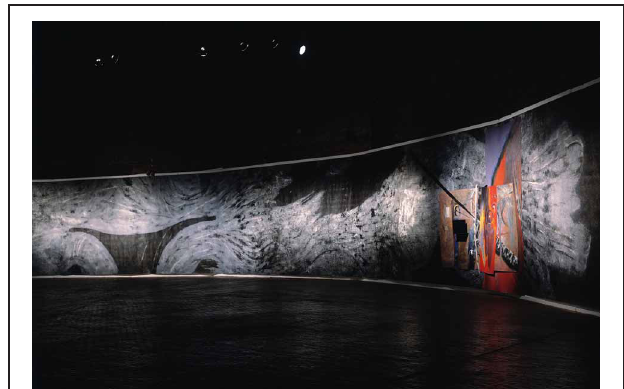
FIGURE 3 | “The Brain Theater of Mental Imagery” (1983). Mixed mediums on spunbonded synthetic canvas, 12 × 100 ft., with mounted paintings and white light hologram, Installation view: Boston Center for the Arts,